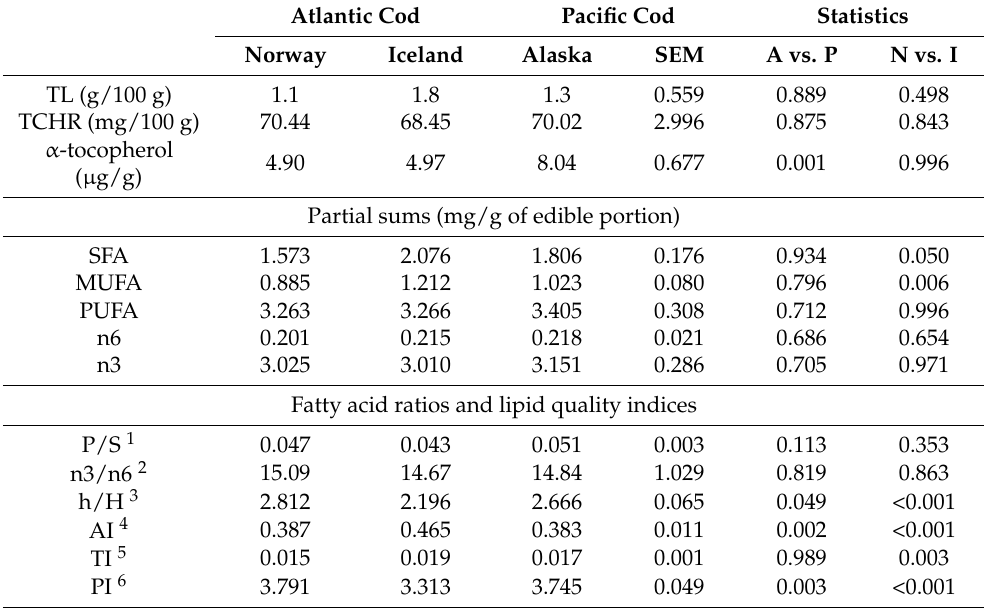
Table 1. Total lipid (TL), total cholesterol (TCHR) and α -tocopherol contents, fatty acid partial sums, fatty acid ratios and lipid quality indices of dried salted cod edible portion obtained from the Atlantic and Pacific cod species and different harvesting locations within the Atlantic